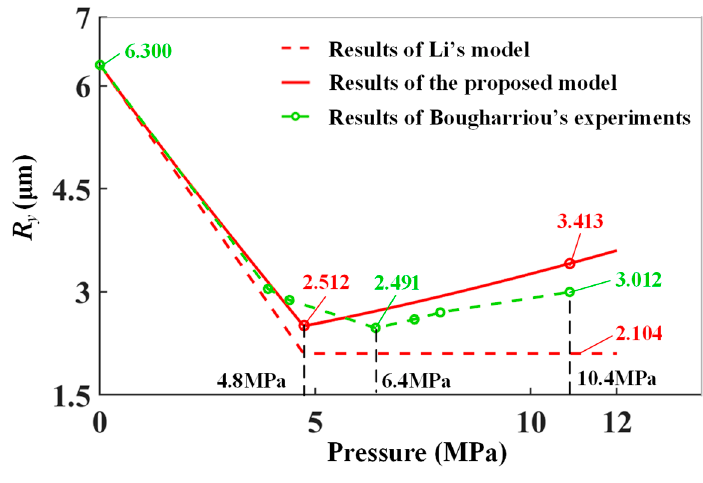
Figure 8. Comparison between experimental results and prediction values.